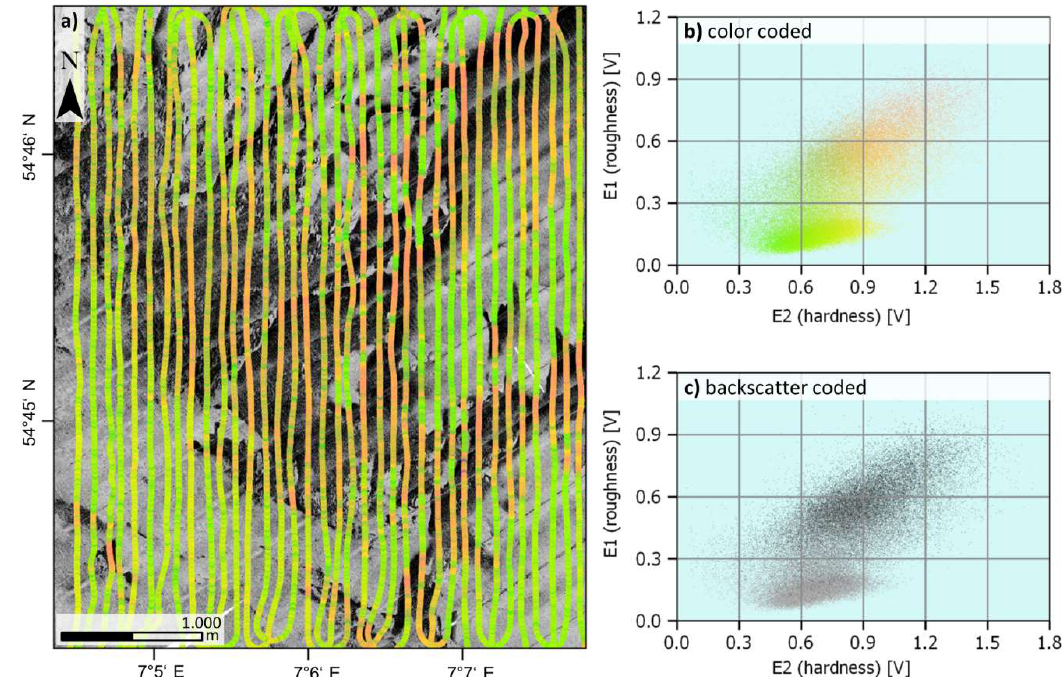
Figure 5. ( a ) Low resolution SSS backscatter mosaic (1 m, high backscatter is dark colored) with acoustic ground discrimination systems (AGDS) RoxAnn track color-coded according to ( b ). ( b ) RoxAnn E1/E2 diagram. ( c ) E1 and E2 values colored in the corresponding SSS backscatter gray values. Two classes are suggested: light gray = lower E1/E2 values and dark gray = higher E1/E2 values.